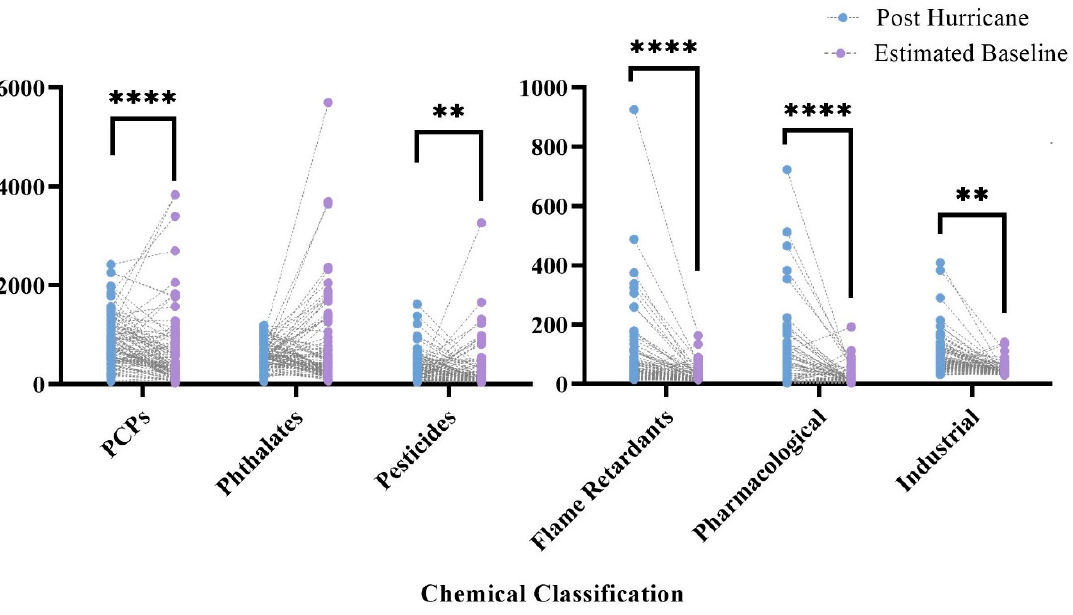
Figure 2. Sum concentration of chemical classifications (i.e., personal-care products (PCPs), phthalates, pesticides, flame retardants, and pharmacological and industrial products) for matched pairs across timepoints. Comparisons represent results from Wilcoxon matched-pair signed-rank tests ** ( p < 0.01), **** ( p < 0.0001).